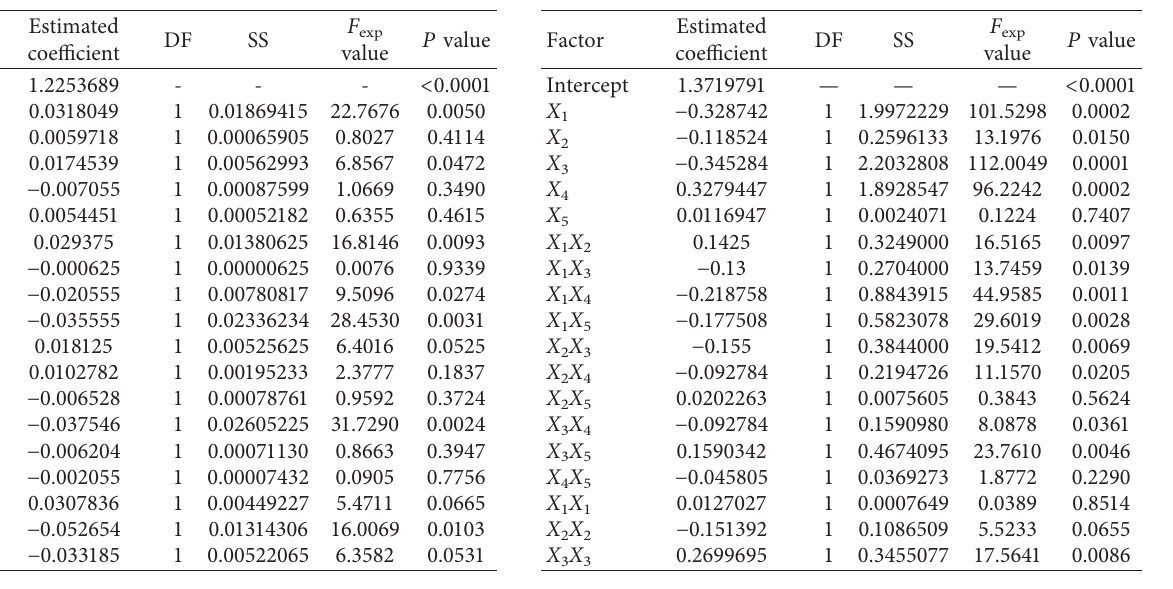
Table 6: Model coefficient estimated by multiple linear of %O 22 − 2